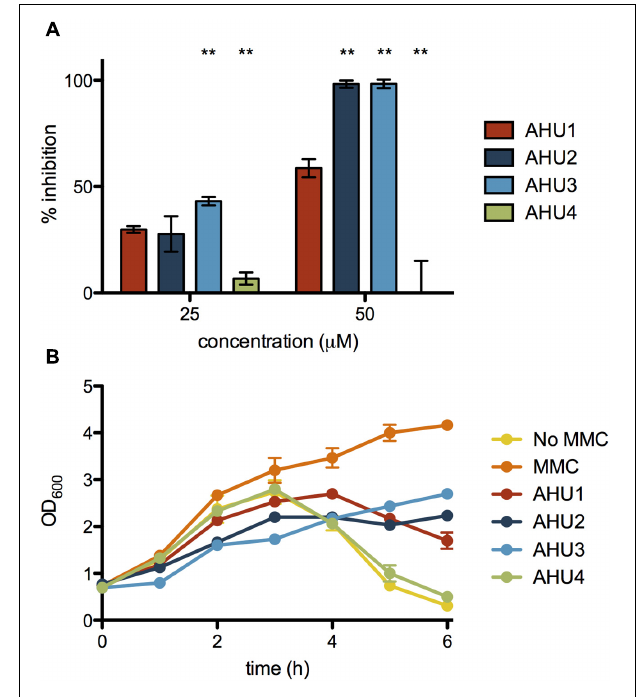
FIGURE 4 | Inhibition of stx2 ::GFP expression and MMC-induced lysis by AHU1-4. (A) Inhibition of stx2 ::GFP expression by 25 and 50 µ M AHU1-4 at 6 h after addition of AHU1-4 and MMC. Data were calculated from triplicate experiments and displayed as the mean inhibition with error bars showing the standard deviation from the mean. Asterisks indicate a significant difference ( ∗∗ p < 0.001) from the original AHU1 concentration inhibition, determined by Student’s unpaired t -test. (B) Inhibition of MMC-induced bacterial lysis after addition of AHU1-4 and MMC. Experiments were performed in triplicate, and data plotted as the mean with standard deviation from the mean displayed by error